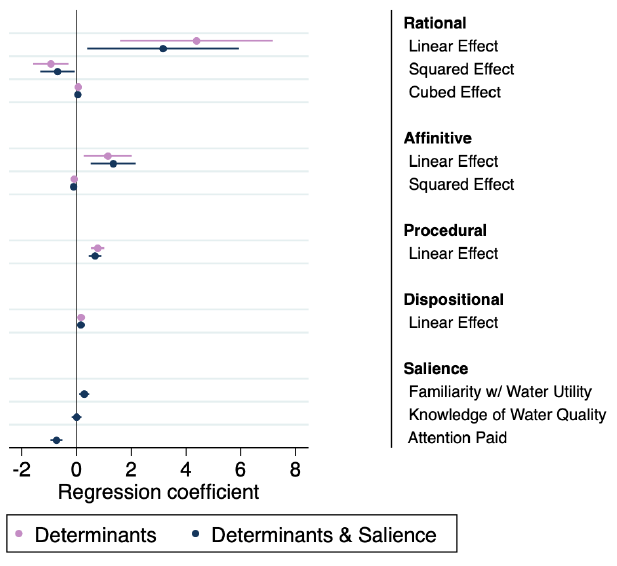
Fig. 3 . Coefficient plot with 95% confidence intervals for regression model of trust determinants only (pink plot) and a regression model that includes salience (blue plot). Table A1.3 contains the full regression output.